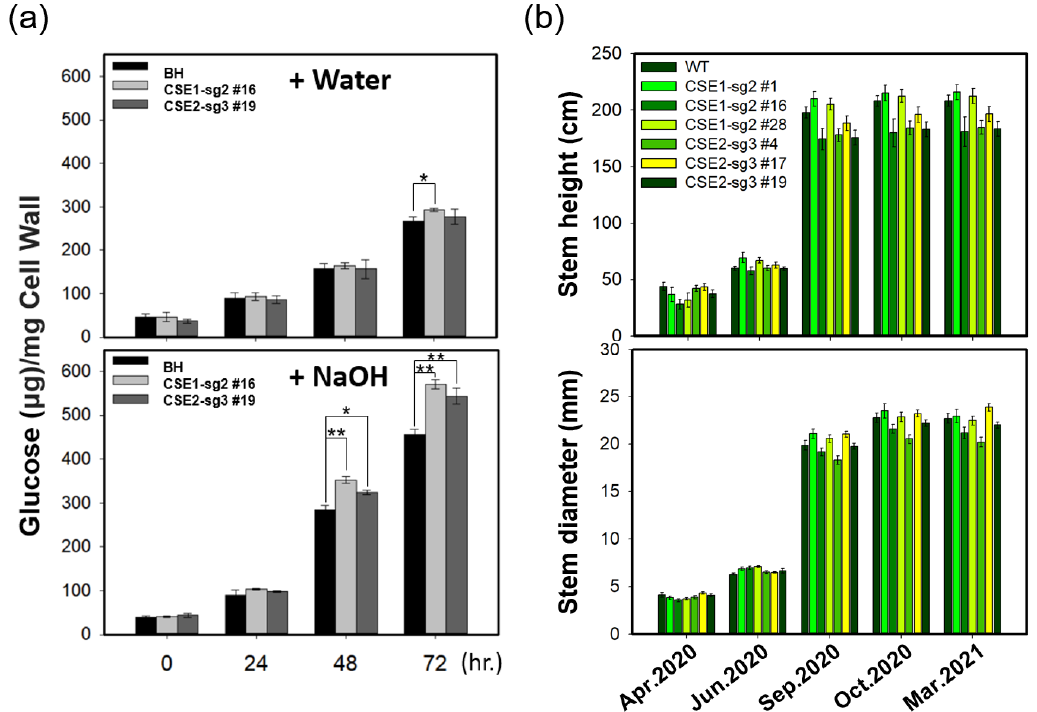
Figure 6. Enhanced saccharification efficiency of transgenic CSE-CRISPR hybrid poplars with normal growth. ( a ) Measurement of saccharification efficiency from BH and transgenic CSE-CRISPR hybrid poplars. Saccharification efficiency was estimated by analyzing the glucose content produced by cell wall materials of woody stems of poplar plants after water (upper panel) or NaOH (lower panel) treatment for the indicated times (see Methods). Error bars indicate S.E. (n = 8) (hour = hr.). Unpaired Student’s t -test, p -value * ( p < 0.05), ** ( p < 0.01), ( b ) Measurement of stem height and diameter at the indicated time (n = 20, Error bars = S.E.).